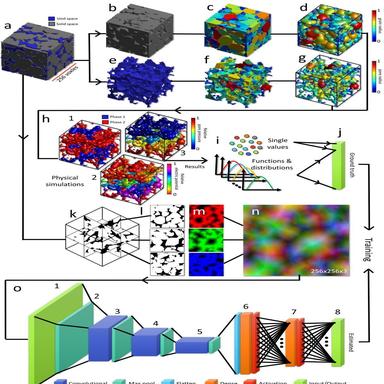
DeePore data workflow for generating the ground truth data and training the CNN based on that, original binary geometry (a), solid and void spaces (b and e), labelled map of nodes (c and f), solid and pore network models (d and g), some of physical simulations on the pore network (h1 to h3), calculated single– value features, as well as the functions and distributions (i), flatten array of ground truth data (j), three perpendicular mid–planes out of the 3–D volumetric data (k), structure of three selected p